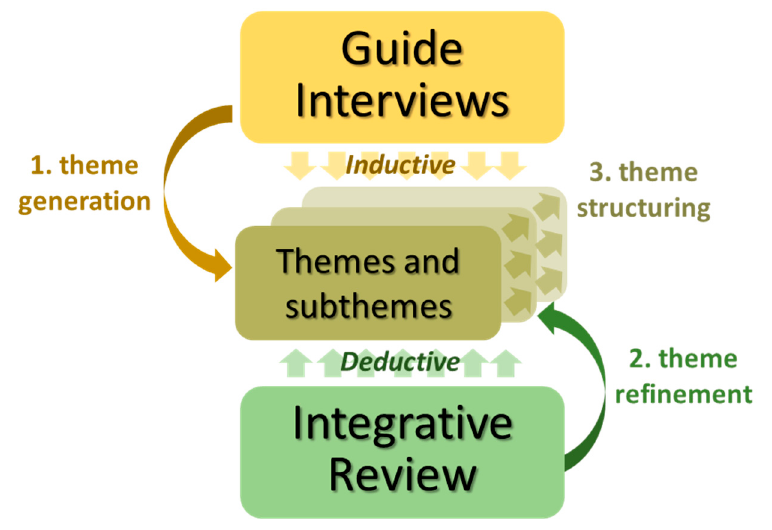
Figure 1. Methodological framework describing the three-stage, inductive–deductive approach to theme development involving theme generation, refinement, and structuring.